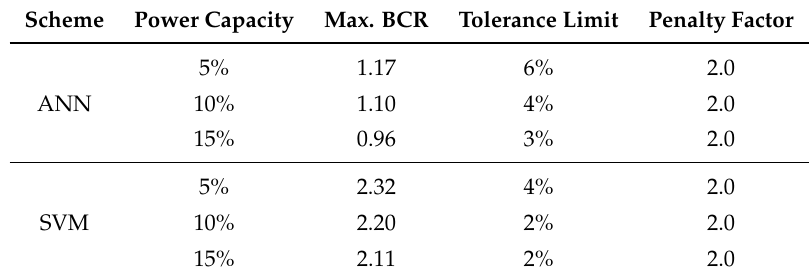
Table 6. The maximum benefit-cost ratio (BCR) value of the ANN and SVM schemes for different power capacities of